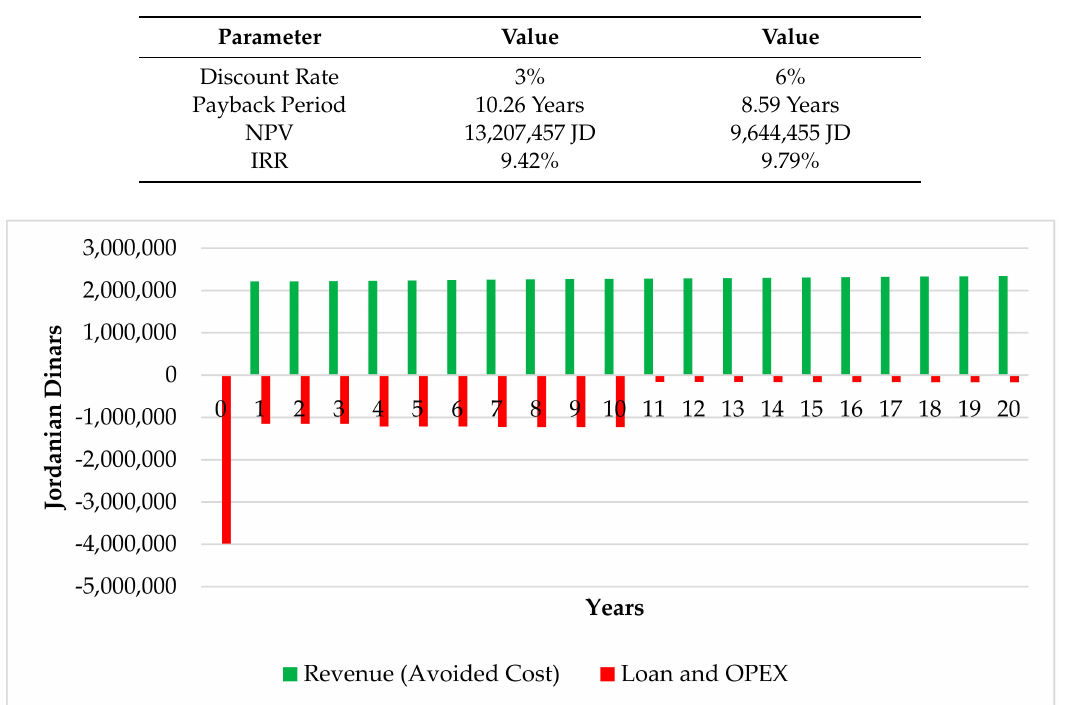
Table 6. Financial analysis for KTD’s hybrid system.